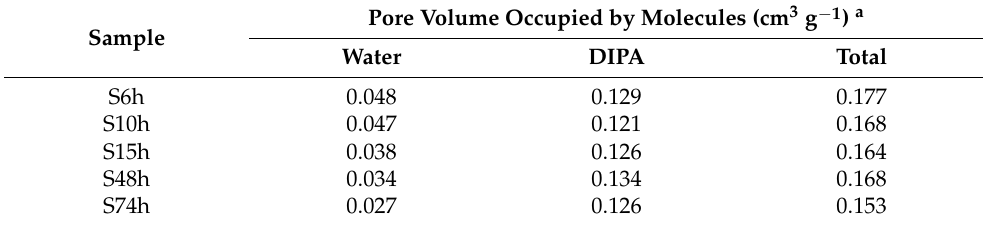
Table 2. Pore volume of the AlPO 4 -11 samples, determined from TG/DTG analyses. Sample